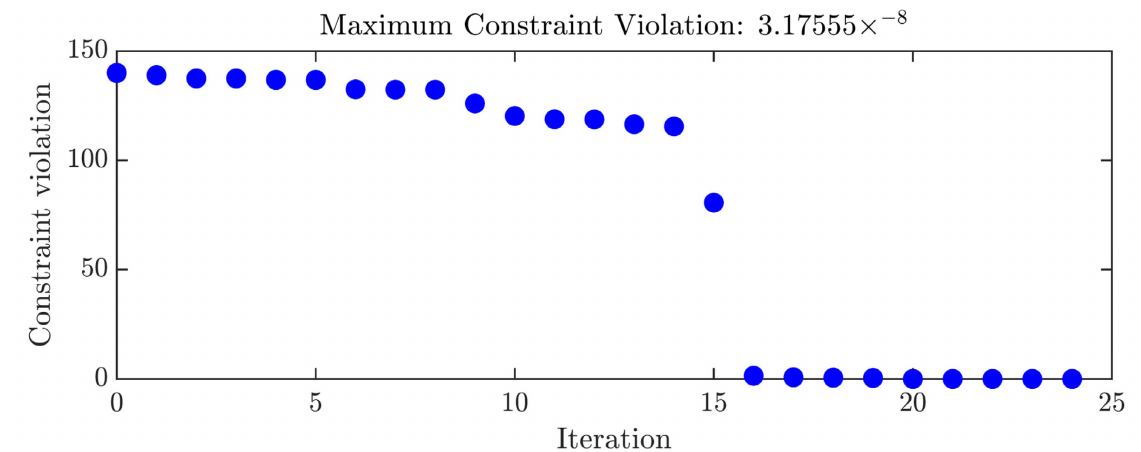
Figure 17. RBDO performance progress for Application